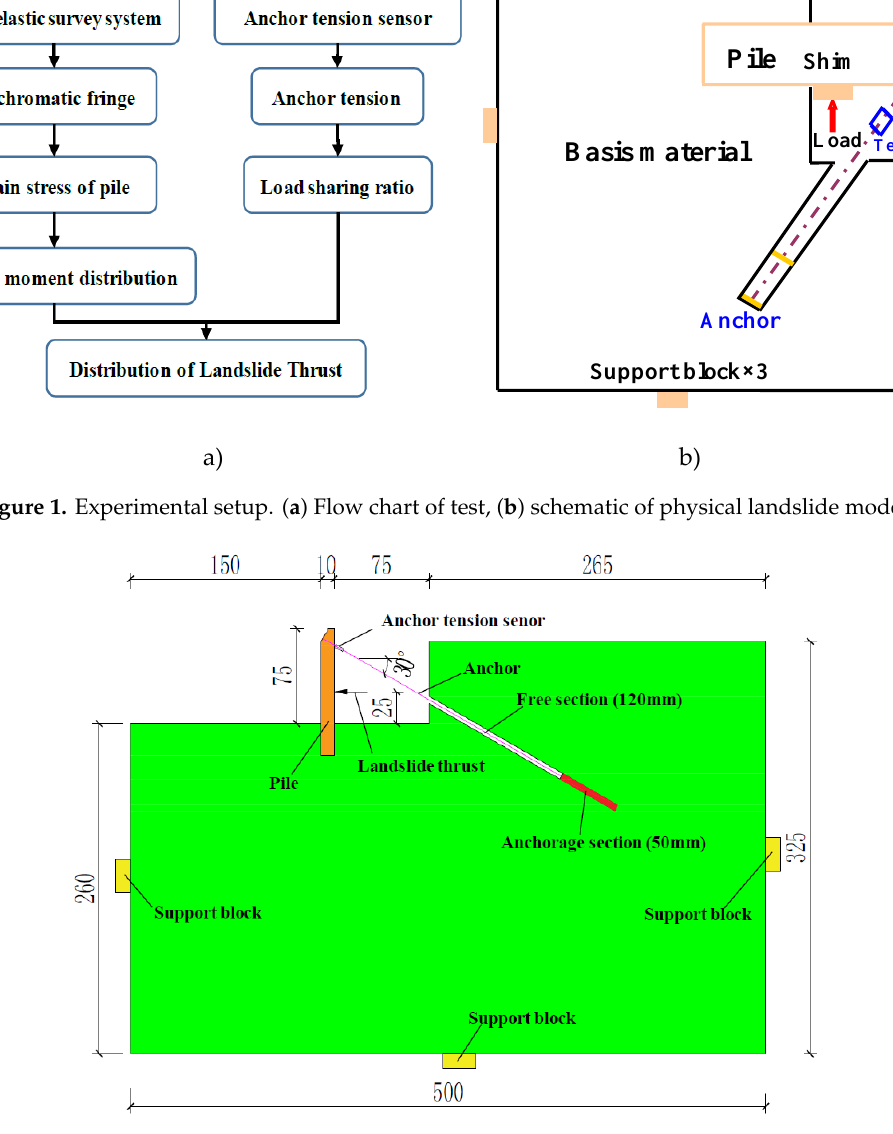
Figure 2. Geometry of physical landslide model (Unit: mm). Table 1. Geometrical sizes of the pile in the model (Unit: